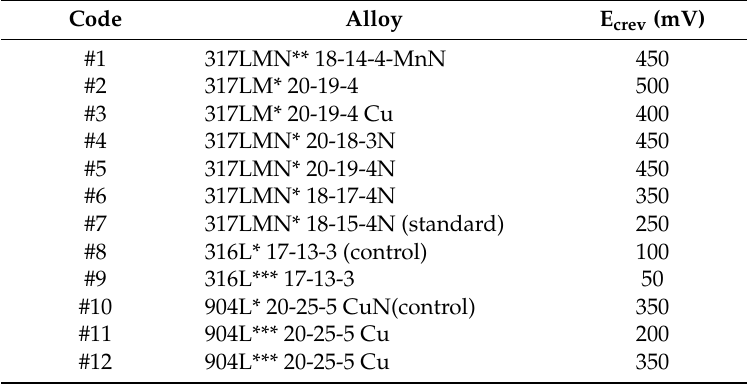
Figure 9. Potentiostatic scan curves for #2 and #11steels evaluated for crevice-pitting corrosion.( a ) #2-